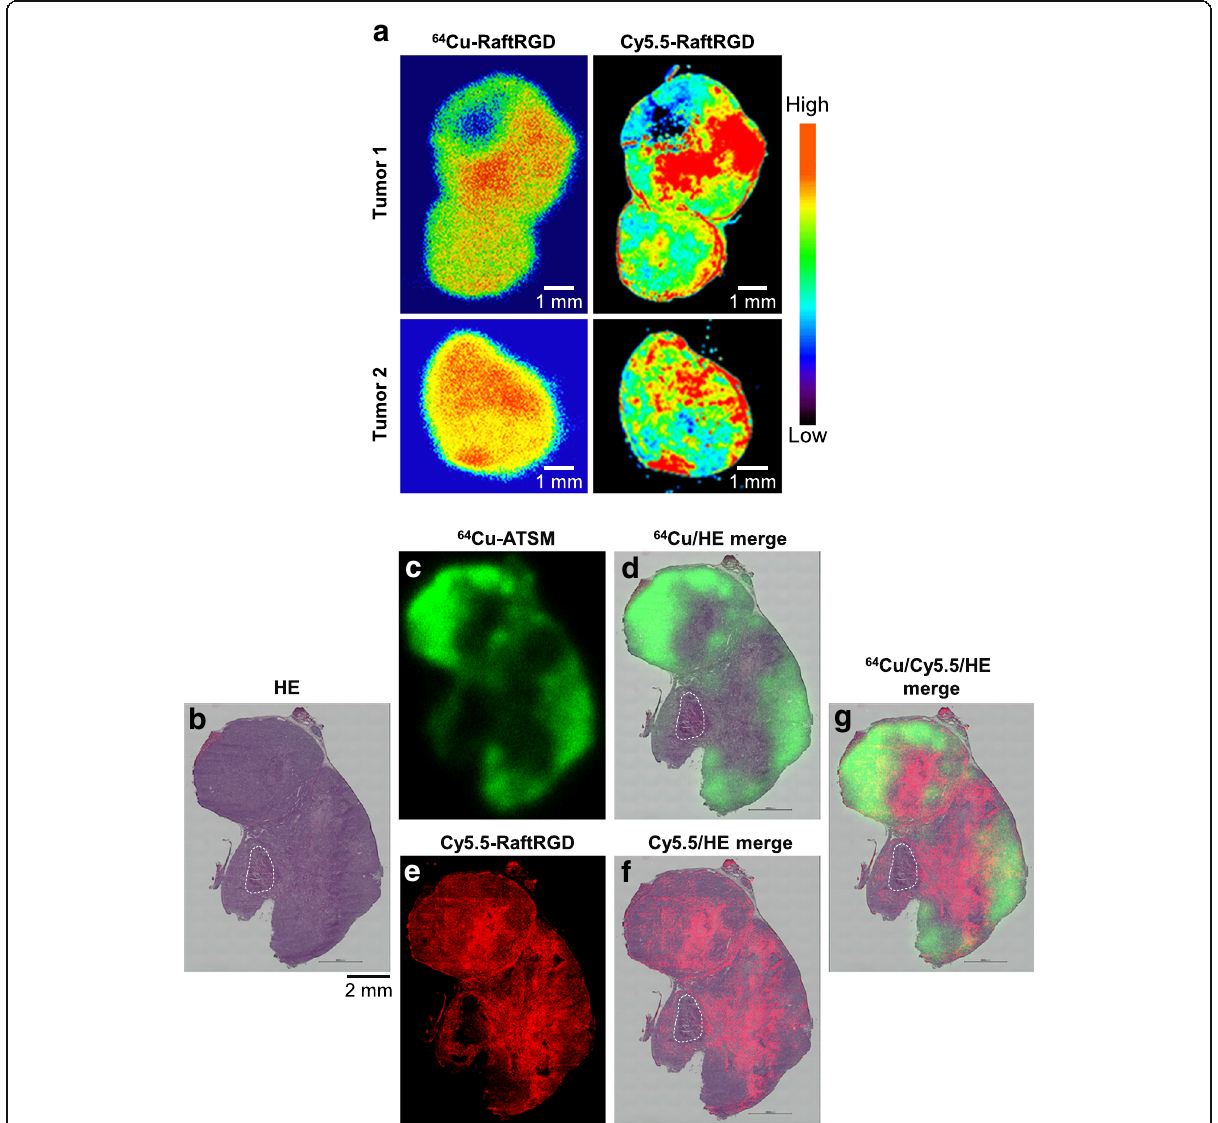
Fig. 2 a Well-matched intratumoral distribution of 64 Cu-RaftRGD and Cy5.5-RaftRGD. Mice bearing U87MG tumors were pre-injected with 37 MBq of 64 Cu-RaftRGD, injected 10 min later with 20 nmol of Cy5.5-RaftRGD, and euthanized at 3 h p.i. Autoradiography and fluorescence imaging were sequentially performed in the same tumor section. Left panels, 64 Cu autoradiograms; right panels, Cy5.5 fluorescence acquired using the Odyssey CLx near-infrared fluorescence imaging system. b − g A representative tumor section showing distribution of 64 Cu-ATSM and Cy5.5-RaftRGD. U87MG tumor-bearing mice were co-injected with 64 Cu-ATSM and Cy5.5-RaftRGD and euthanized at 3 h p.i. Autoradiography, fluorescence imaging, and HE staining were sequentially performed in the same tumor section. b HE staining; c 64 Cu autoradiogram in green; d Merged image of b and c ; e Cy5.5 fluorescence in red; f Merged image of b and e ; g Merged image of b , c , and e . Yellow, red/green overlay. The necrotic region is marked by a dotted line. Scale bar, 2